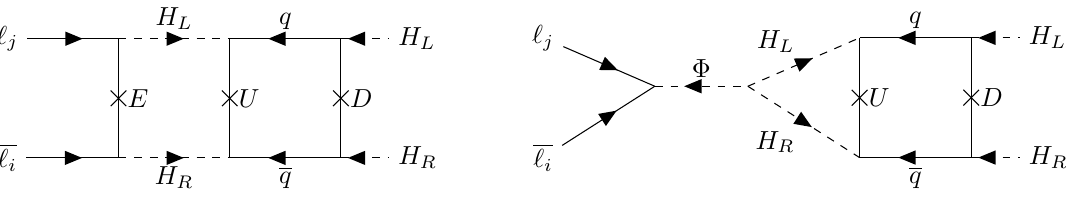
Figure 10 . Two-loop diagrams correcting the decay rate of the dark matter, N 1 , when the charged lepton masses are generated by the exchange of a heavy fermion, E (left), or scalar, Φ (right), and the up-type quark and down-type quark masses are generated by the exchange of heavy fermions, U , D , respectively. Each diagram is a UV completion to the EFT diagram of figure